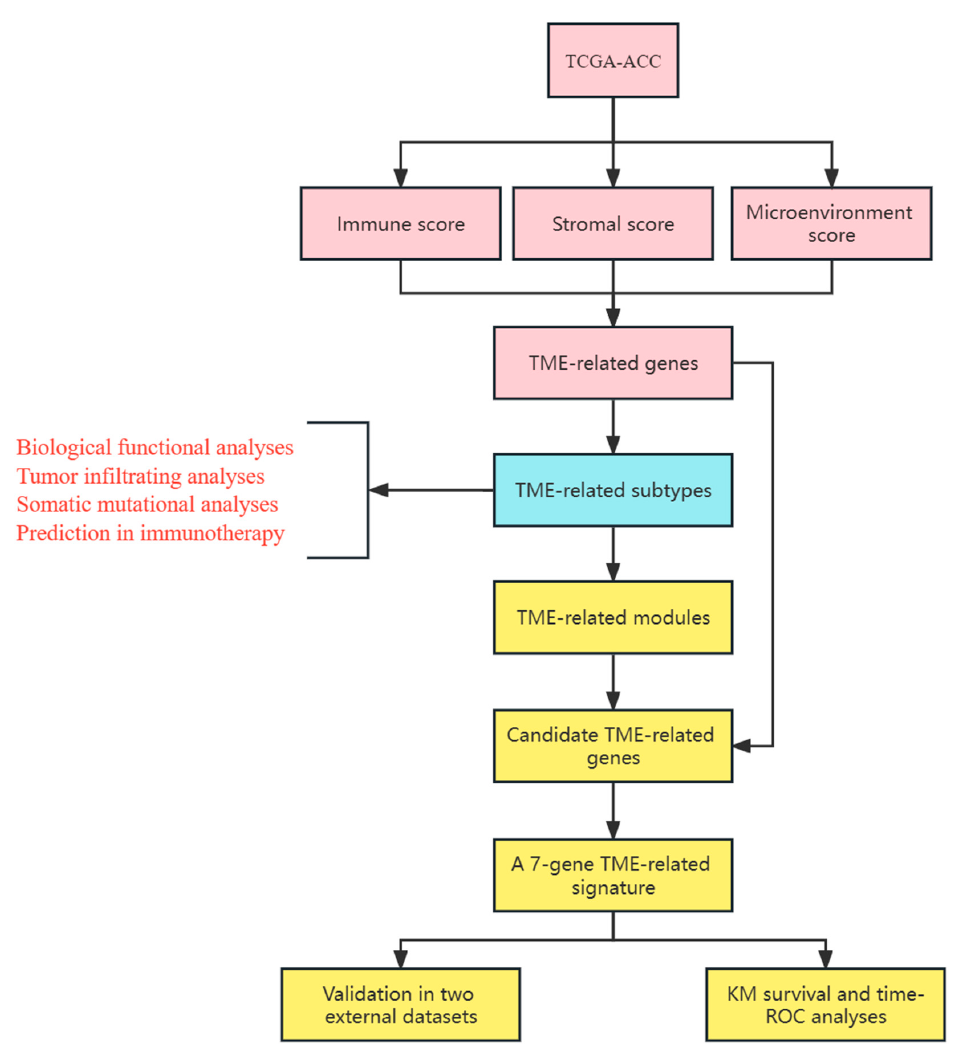
Figure 1. The flow chart of the study.